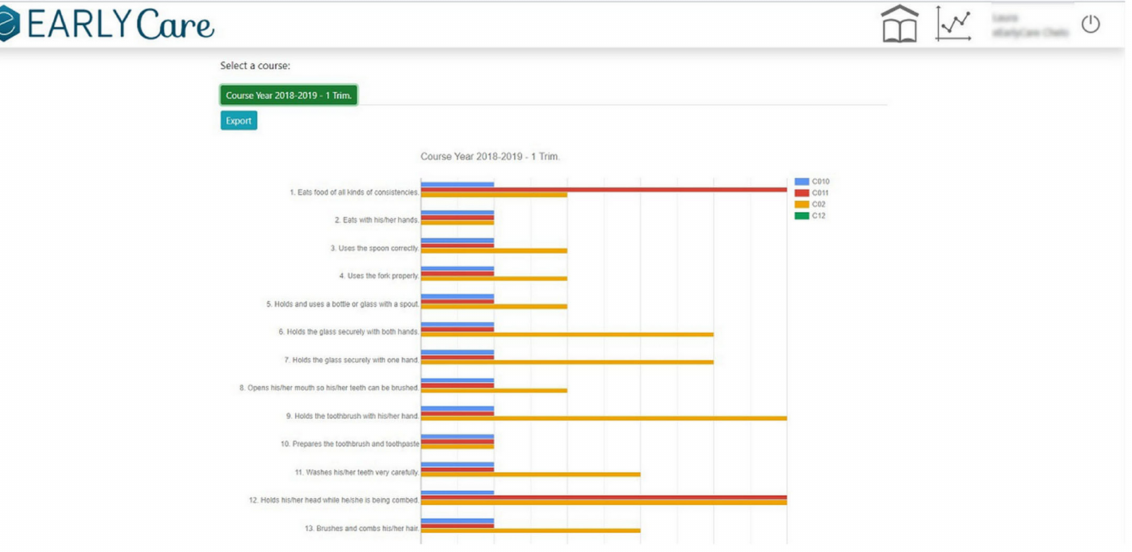
Figure 4. Levels of a patient’s development in each of the abilities that measure each of the behaviors include into each functional